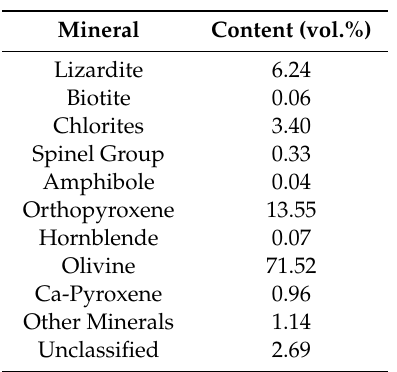
Table 2. Mineralogical composition of the used ore (QEMSCAN © —“Quantitative Evaluation of Minerals by Scanning Electron Microscope”).